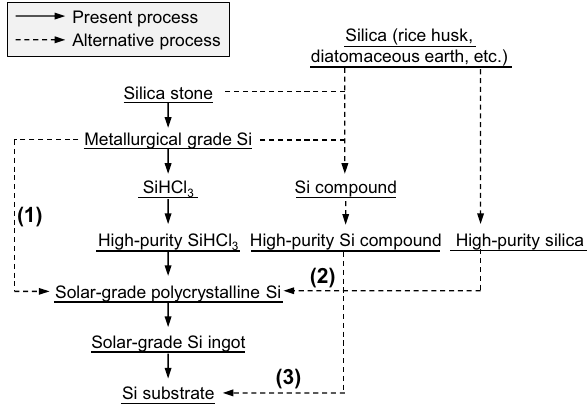
Figure 2: Flowchart for the present and alternative production pro - cesses of Si substrate for solar